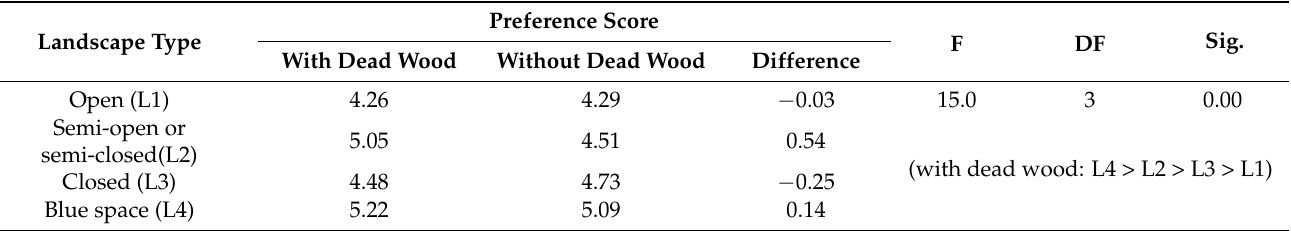
Table 4. One-way ANOVA with Tukey’s HSD post-hoc tests of preferences for dead wood in the different types of environments.